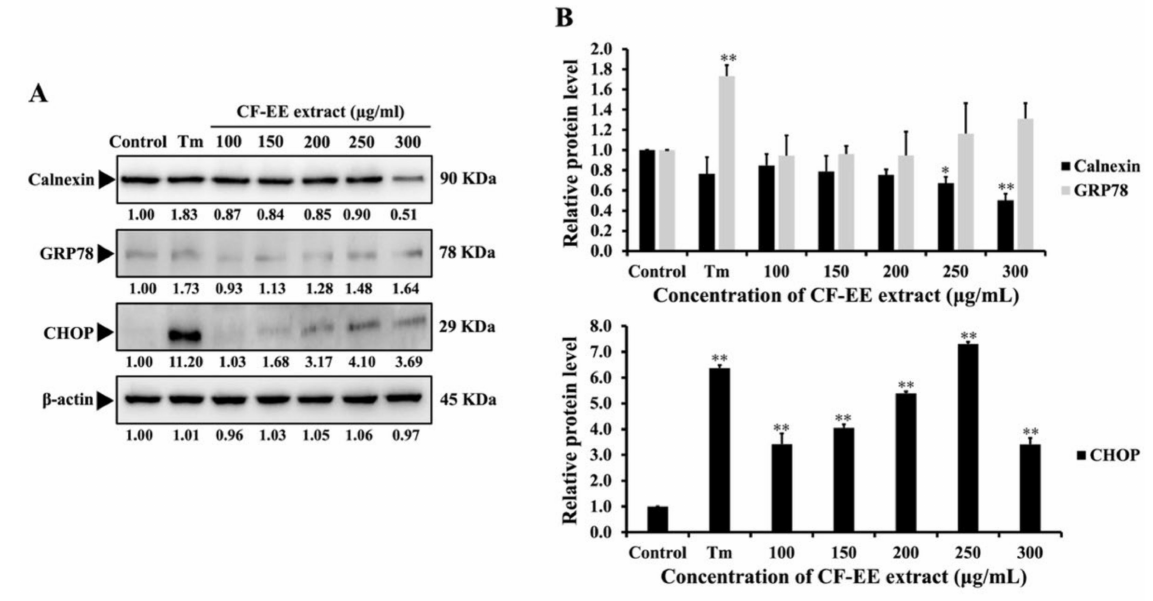
Figure 6. CF-EE extract induced ER stress signaling pathway. HeLa cells were treated with CF-EE extract at various concentrations or 10 µ g/mL of Tm for 24 h. ( A ) Expressions of calnexin, GRP78, and CHOP were determined by Western blotting. ( B ) Relative protein intensity compared to the control, β -actin, was used as an internal control. The values are represented as the mean ± SD. * p < 0.05 and ** p < 0.01 compared to the control.